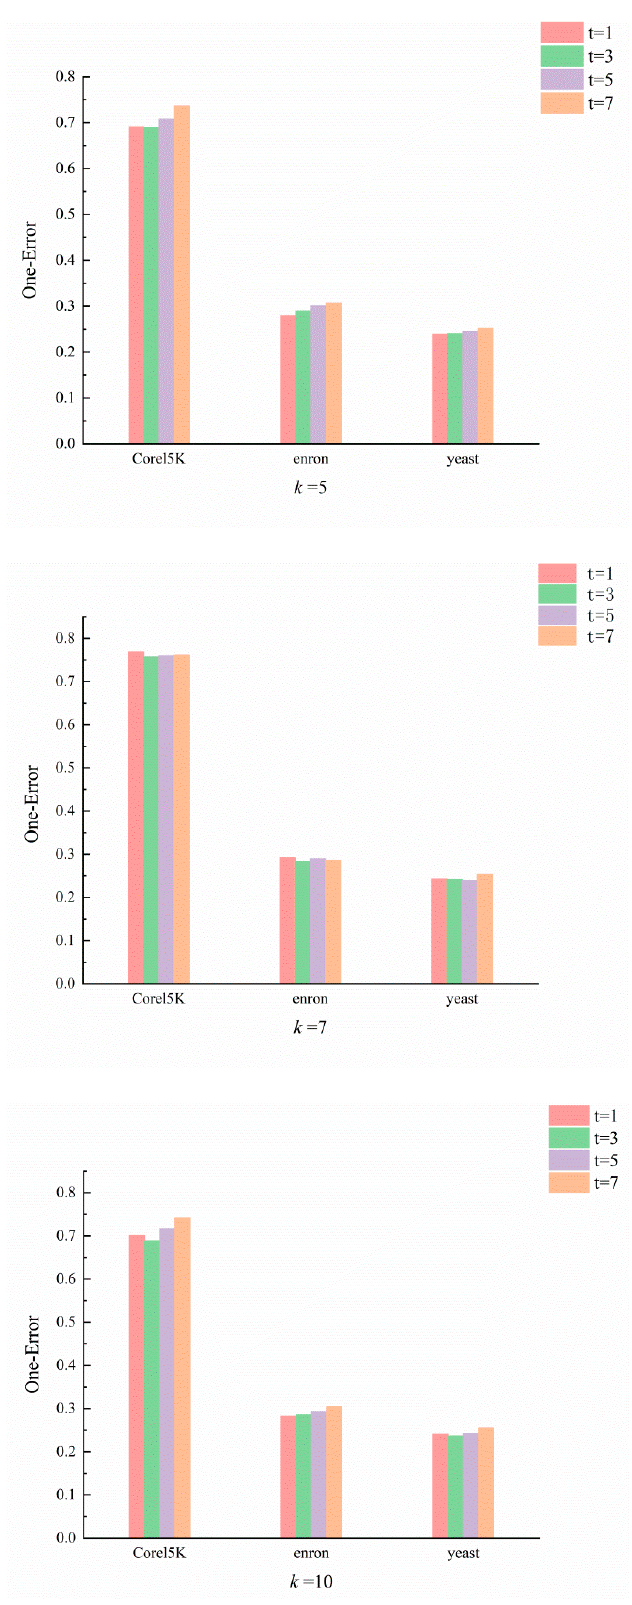
Figure 2. One‑error for different values of k and t in different datasets. Different colors represent different values of t .